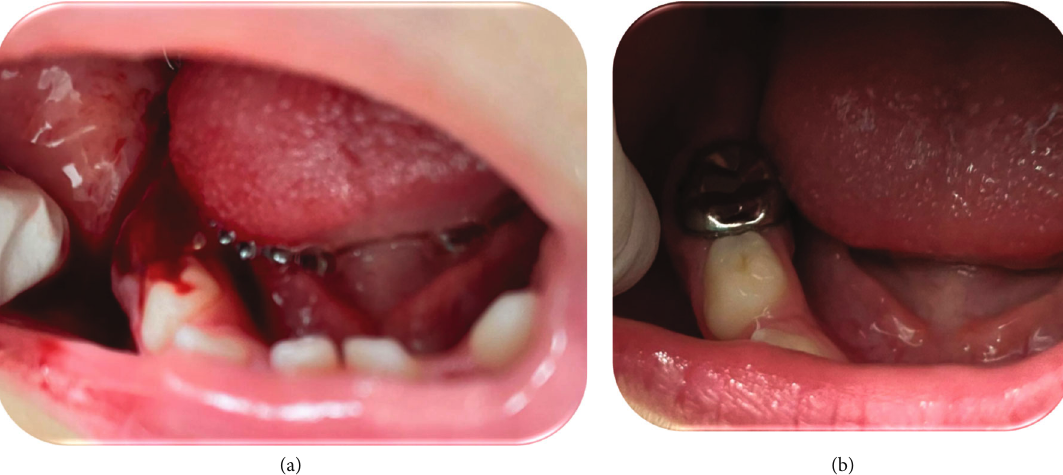
Figure 2: Patient case 4. (a) Excessive bleeding and a blood clot in the mouth of a 4.5-year-old girl 3 days after placing SSCs. (b) The bleeding continued for 18 hours after rinsing the mouth for 30 minutes.